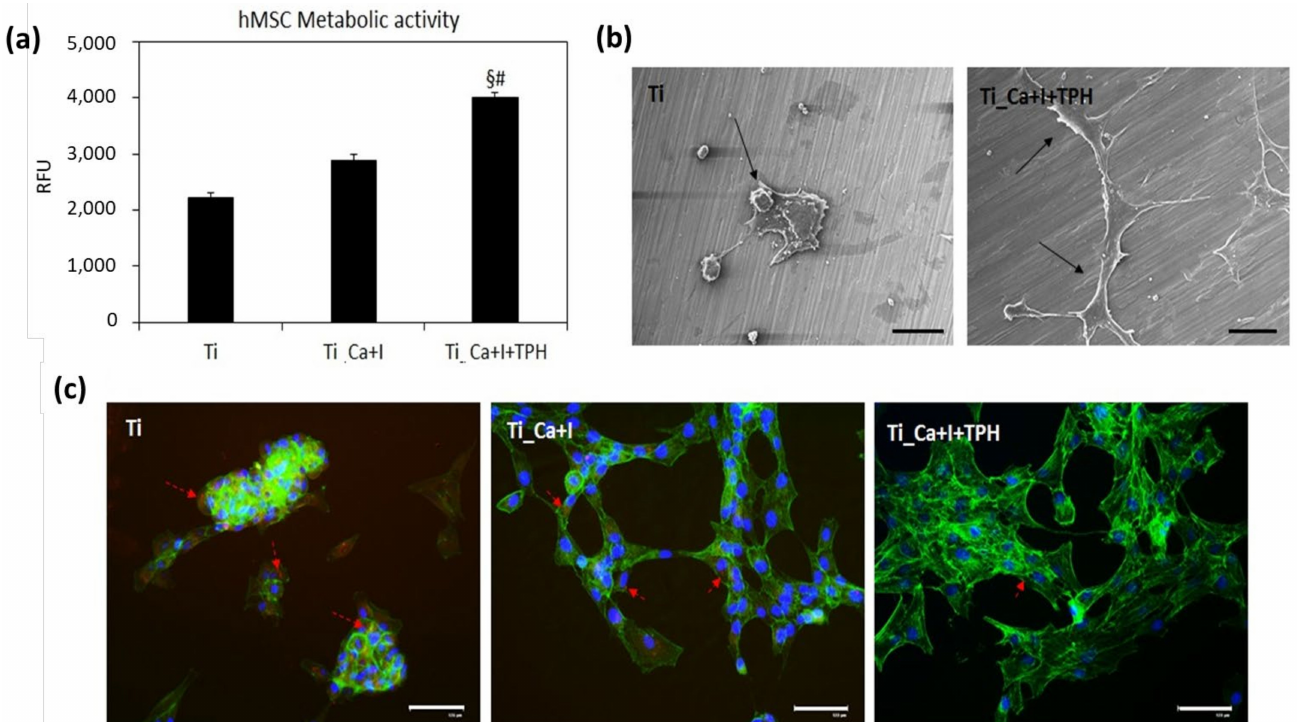
Figure 11. Pro-inflammatory evaluation. When the inflammatory environment was generated after cell seeding, the presence of iodine + polyphenols (Ti_Ca+I+TPH) protected cells from oxidative stress, as the highest metabolism was highest (( a ), p < 0.05 in comparison with Ti and Ti_Ca+I, indicated by § and #, respectively), and a proper morphology in the SEM images ( b ). The toxic effect was due to the active species internalization as shown in the CellRox staining (( c ), positive cells stained in red), where most of the cells were protected by the iodine and polyphenol. Bars represent means ± st. dev, replicates = 3. SEM images: 180 × magnification, bar scale = 100 µ m; fluorescent images bar scale = 125 µ